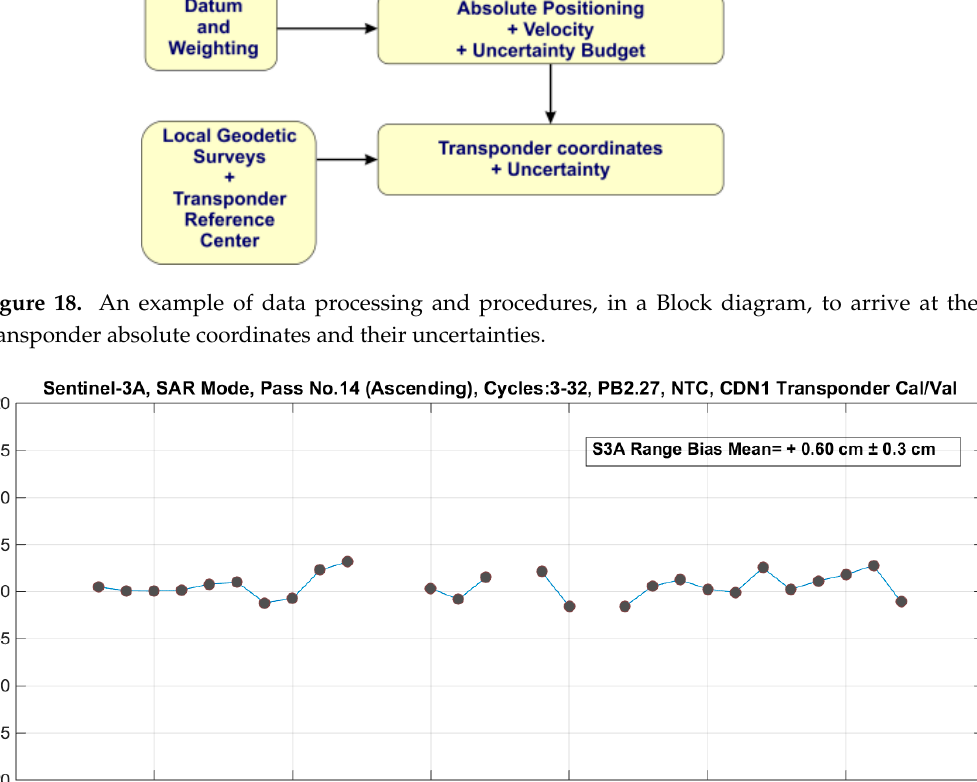
Figure 19. Absolute range bias results for the ascending Sentinel-3A Pass No.14, Cycles 3–32 at the CDN1 Cal/Val site.